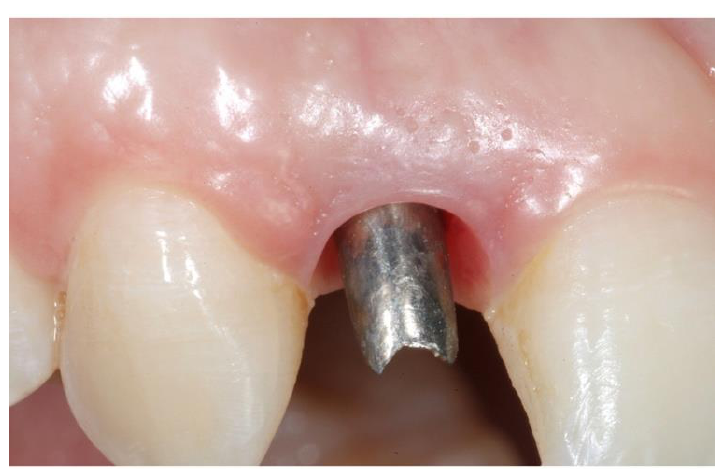
Figure 2. Detail of the titanium abutment after peri-implant soft tissues conditioning.